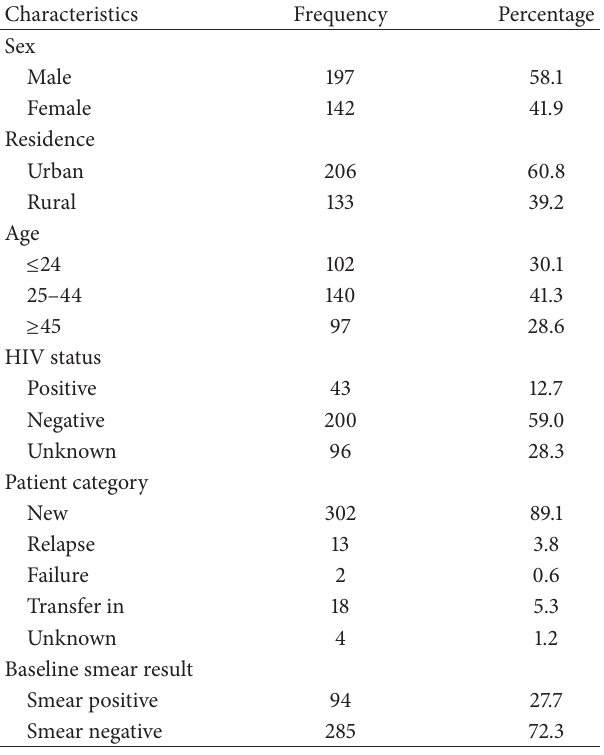
Table 1: Characteristics of TB patients ( 𝑁 = 339 ), Debre Tabor Health Center, 2008–2013.